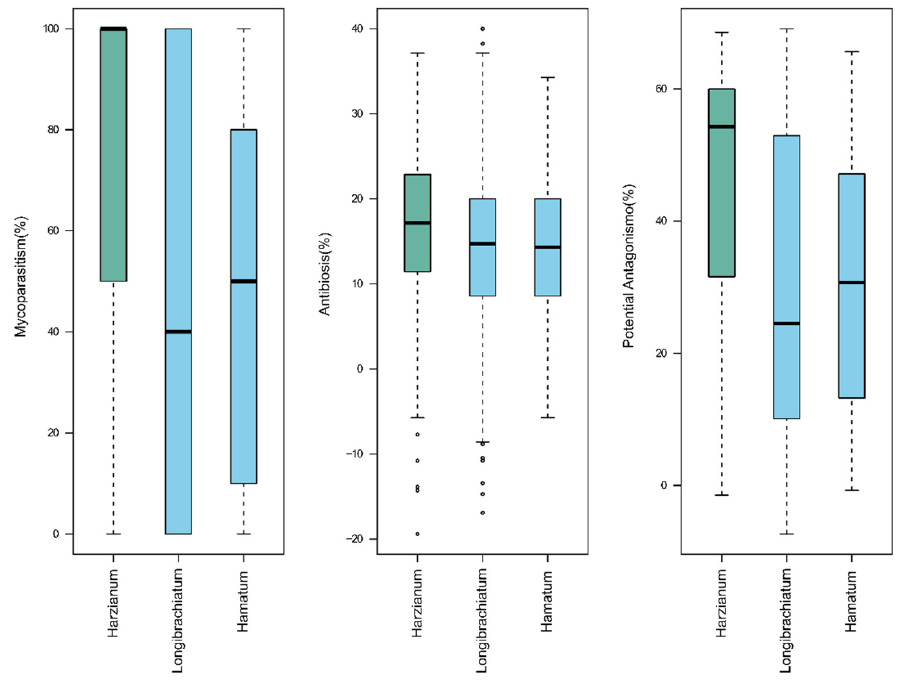
Figure 3. Mycoparasitism, antibiosis, and potential antagonism levels of the 234 Trichoderma strains grouped by phylogenetic clade. Boxplots with different colors in each plot indicate that the ranked median of mycoparasitism, antibiosis, or potential antagonism of strains within a phylogenetic clade differ significantly ( p < 0.05) according to the Kruskal–Wallis test.